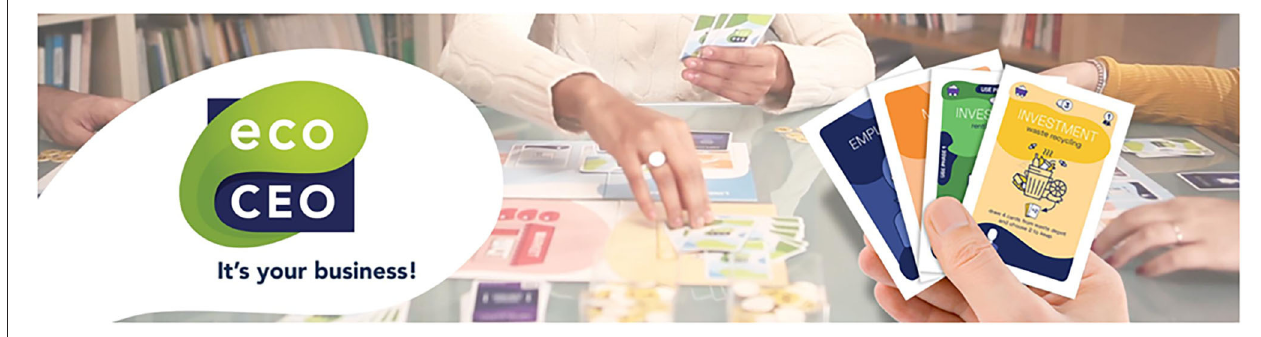
FIGURE 1 | Game materials.